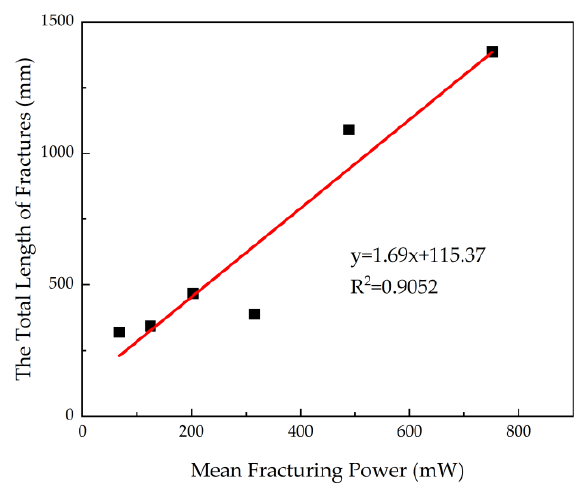
Figure 15. Influence of mean fracturing power on the fracture length.